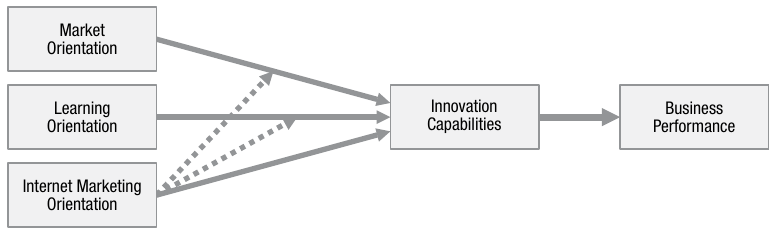
Fig. 1. The proposed conceptual